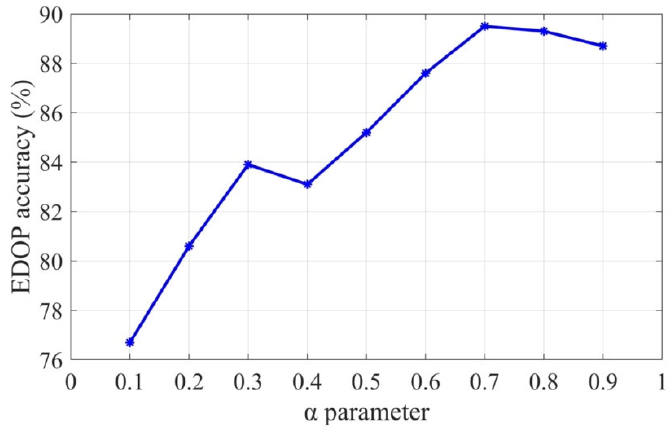
Figure 16. Relationship between the parameter of α and EDOP accuracy. Table 1. A comparison of EDOP accuracy of the four extraction methods under the three distances.